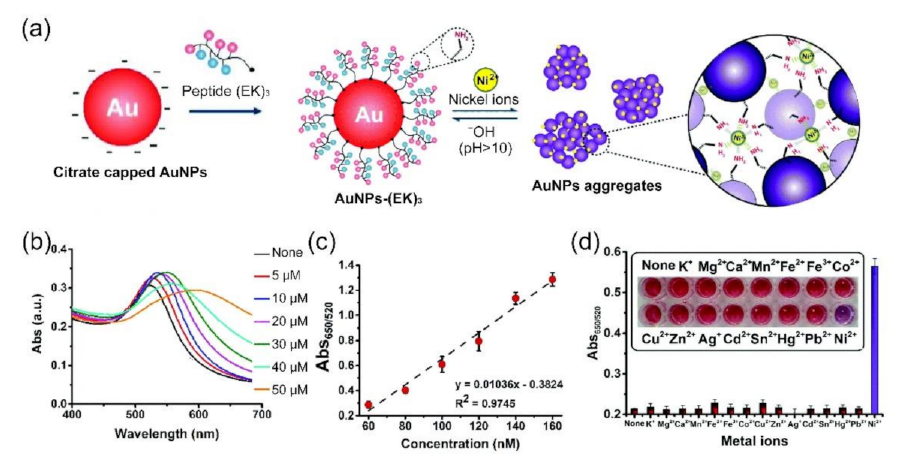
Figure 3. AuNP-(EK) 3 nanoprobe-based colorimetric detection of Ni 2+ . ( a ) Schematic illustration of AuNP-(EK) 3 nanoprobe preparation and detection principle of Ni 2+ , ( b ) UV–visible absorption spectra of AuNP-(EK) 3 at different concentrations of Ni 2+ (0–50 µ M), ( c ) linear calibration plot of AuNP-(EK) 3 versus Ni 2+ concentrations in the range of 60–160 nM, ( d ) selectivity of AuNP-(EK) 3 toward different metal ion species. The zwitterionic region of the (EK) 3 -peptide can bind to Ni 2+ due to the presence of an -NH 2 or -COOH group and the unfilled d-orbital of Ni 2+ , leading to the aggregation of AuNPs. As a result, in the presence of Ni 2+ , the color of the AuNP-(EK) 3 solution is changed from red to purple. (Adapted from Parnsubsakul et al. 2018 [79], Copyright 2018 The Royal Society of Chemistry and reproduced with